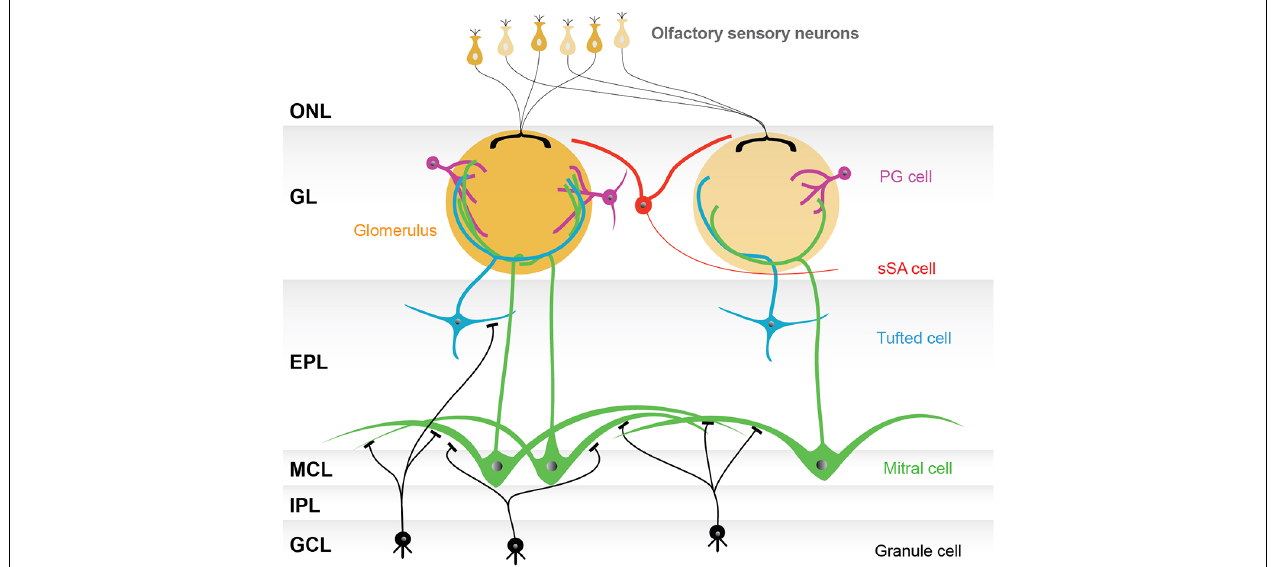
send their axons to the olfactory cortex.The somata of mitral cells are located in the mitral cell layer (MCL), while the tufted cells are scattered throughout the EPL. Both mitral and tufted cells project a single primary dendrite into a single glomerulus, where they receive synaptic inputs from the axons of olfactory sensory neurons and make reciprocal synapses with the dendrites of PG cells. Secondary dendrites of mitral and tufted cells are elongated in the external plexiform layer (EPL), where reciprocal synapses are formed with granule cell dendrites.The internal plexiform layer (IPL), in which axons from mitral cells and axon collaterals of ET cells run, and the granule cell layer (GCL), which is largely composed of granule cells, both lie beneath the MCL. Granule cells are axon-less interneurons extending dendrites apically into the EPL. Abbreviation: ONL, olfactory nerve